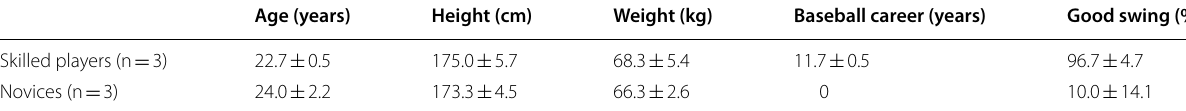
Table 2 Participant characteristics and difference between skill levels detected by proposed